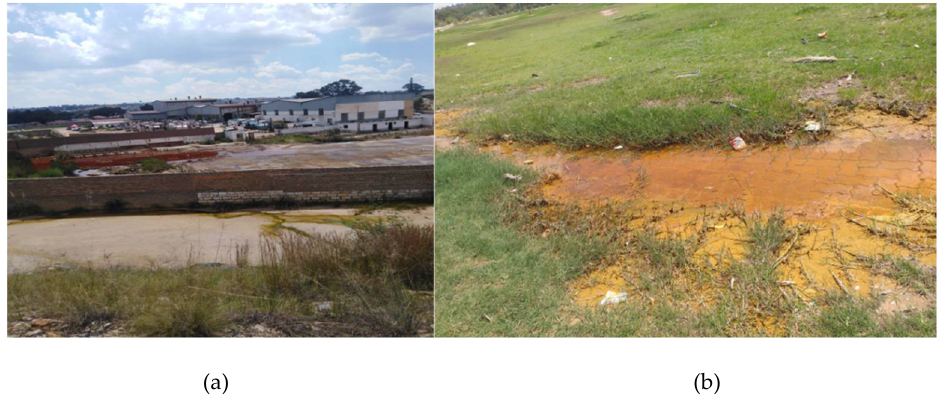
Figure 1. Environmental problems caused by Princess Goldmine Dump (( a ) to human settlement, factory, and ( b ) Manuel Street Park).